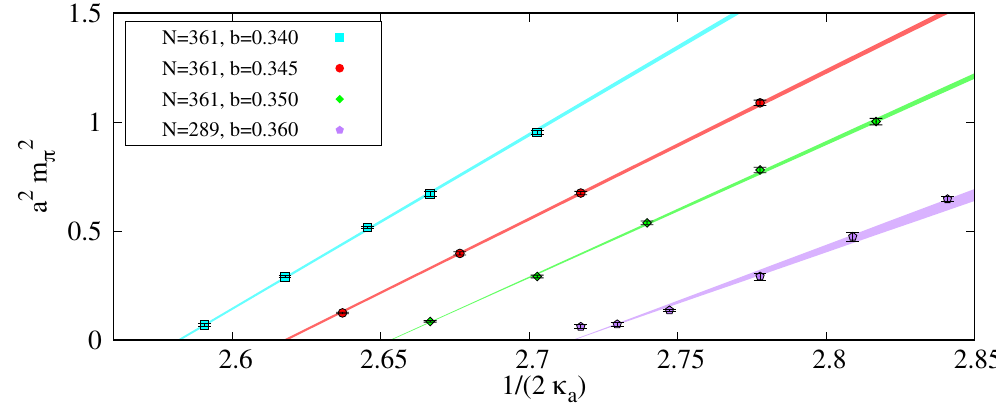
Figure 3. Dependence of the PCAC adjoint fermion mass on 1 / (2 κ bare coupling b and larger value of N within our set of simulations. The bands are linear fits at fixed value of b used to determine the critical value of the adjoint hopping parameter κ c width indicating the error in the fit. The χ 2 per degree of freedom of each of the fits is indicated in the legend.